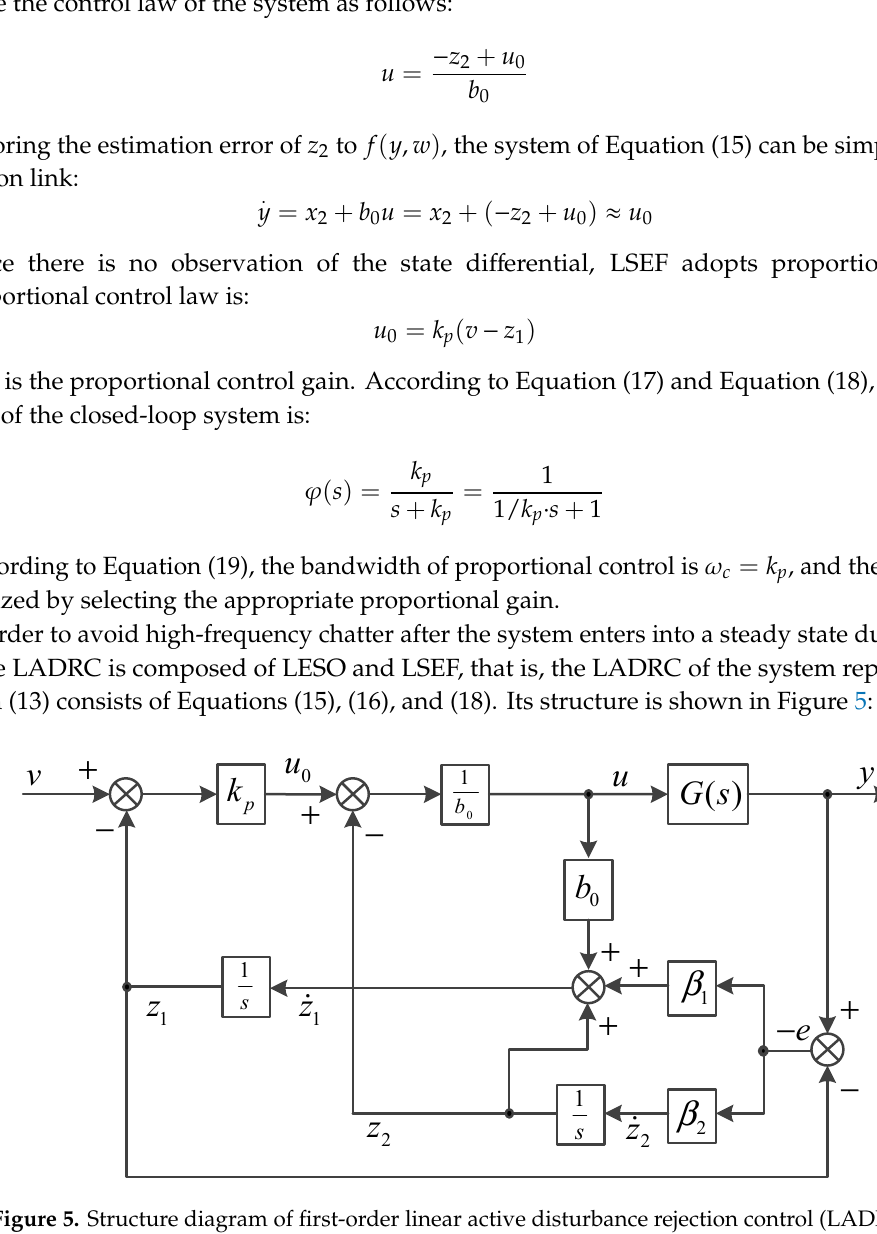
Figure 5. Structure diagram of first-order linear active disturbance rejection control (LADRC).